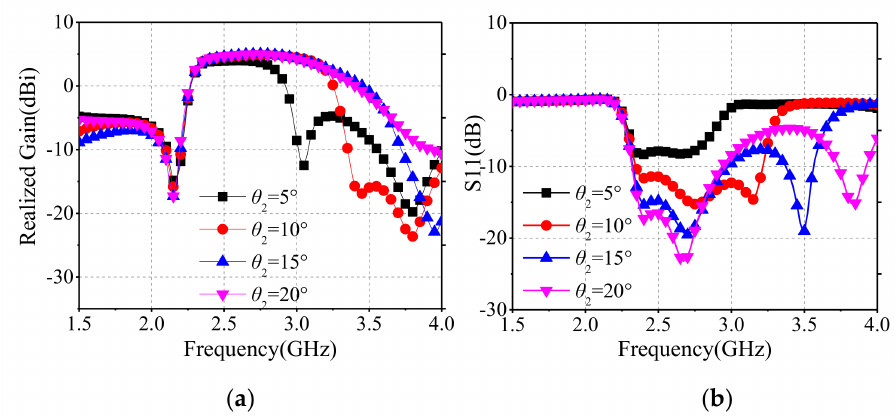
Figure 10. Simulated results for different parameter θ 2 , ( a ) realized gain, ( b ) S11.